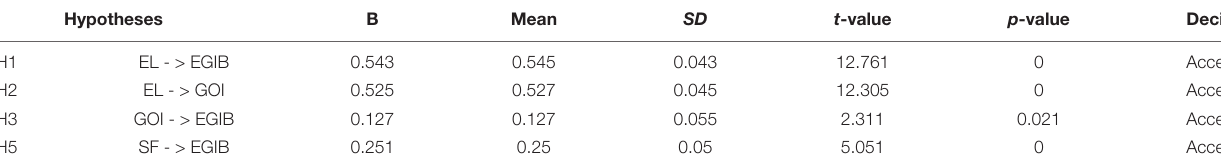
TABLE 5 | Path coefficients for direct relations.